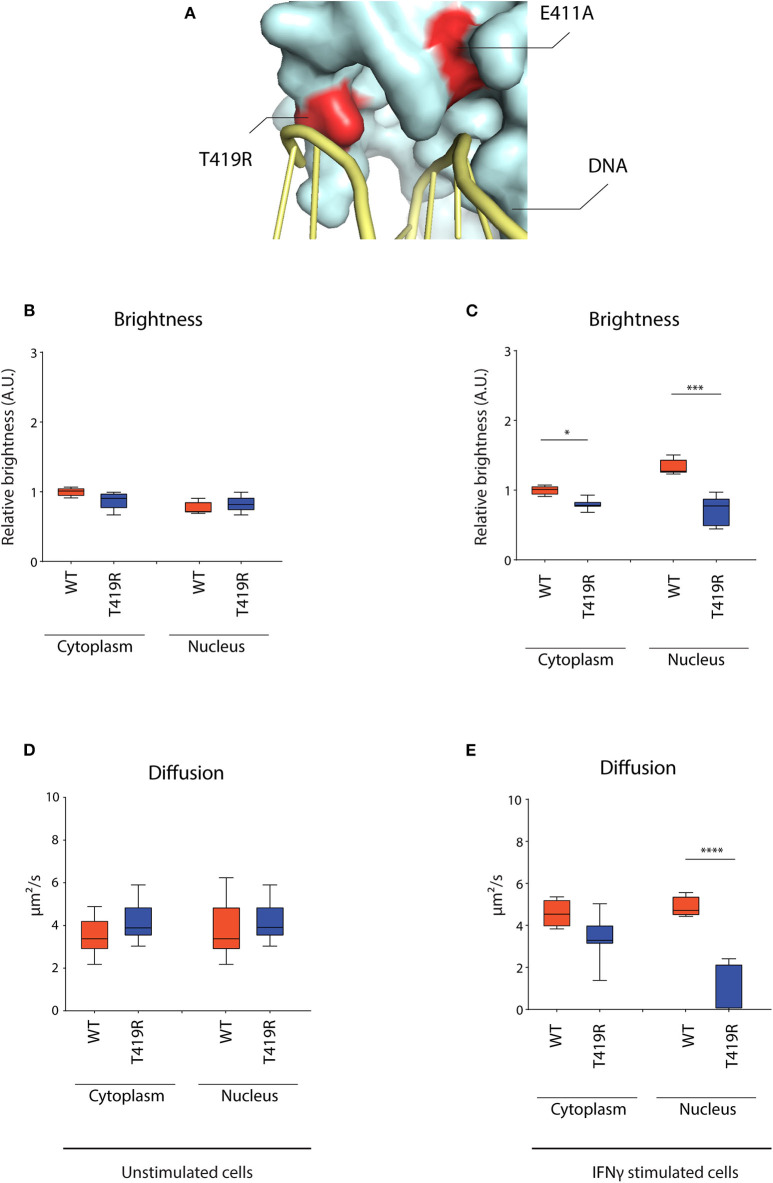
RICS analysis of STAT1-GFP WT and T419R GOF mutant in U3A cells. (A) Detail of crystal structure of STAT1 bound to DNA. Highlighted in red are the T419R and the E411A mutations, situated in close proximity of the DNA. (B) Average brightness in unstimulated condition and (C) after IFNγ stimulation. (D) Average diffusion constant in unstimulated condition and (E) after IFNγ stimulation. Data in panels (B–E) (n > 7) are represented in box and whiskers plot. The central line represents the median, while the box extends from the 25th to 75th percentiles with whiskers spanning 10–90% intervals. Dots outside these intervals are represented as single dots. Statistical analysis: One-way ANOVA with Tukey's post-hoc test. *P < 0.05; ***P < 0.001; ****P < 0.0001.